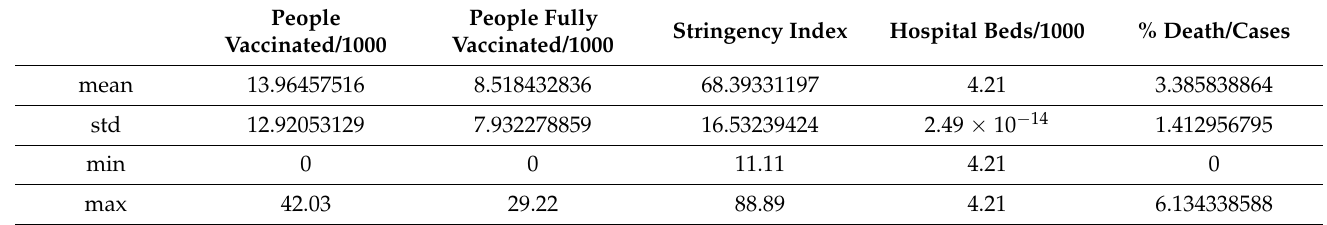
Table 4. Pandemic Statistic